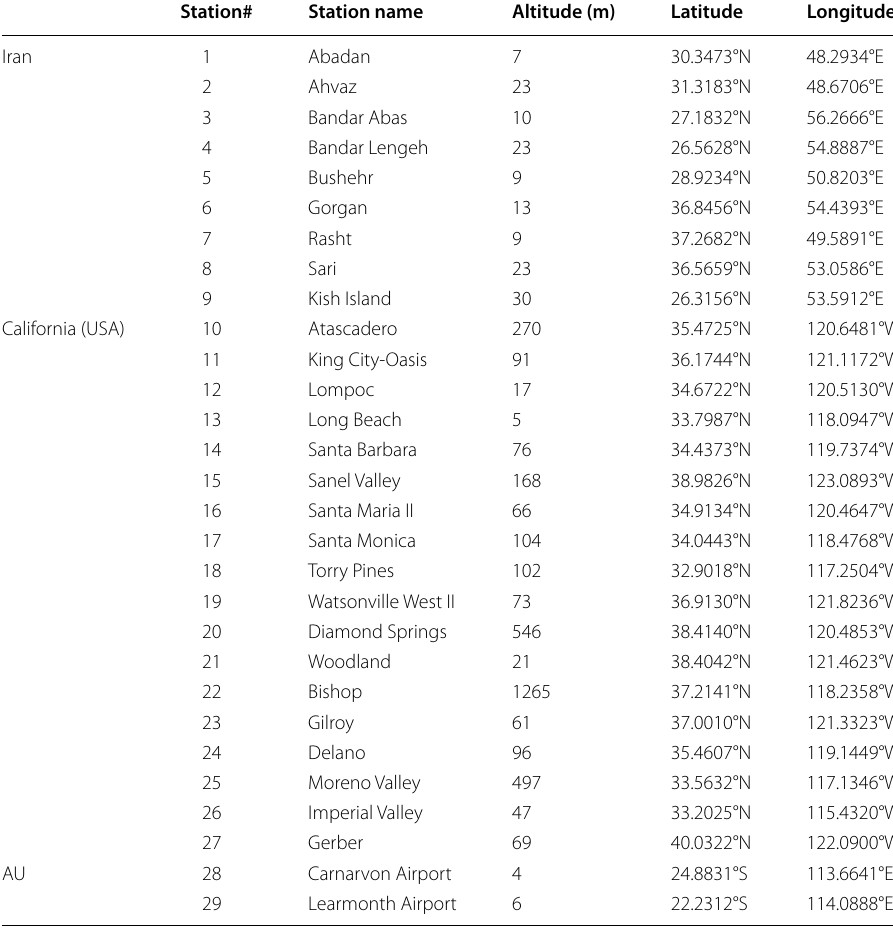
Table 4 The geographical locations of the selected weather stations